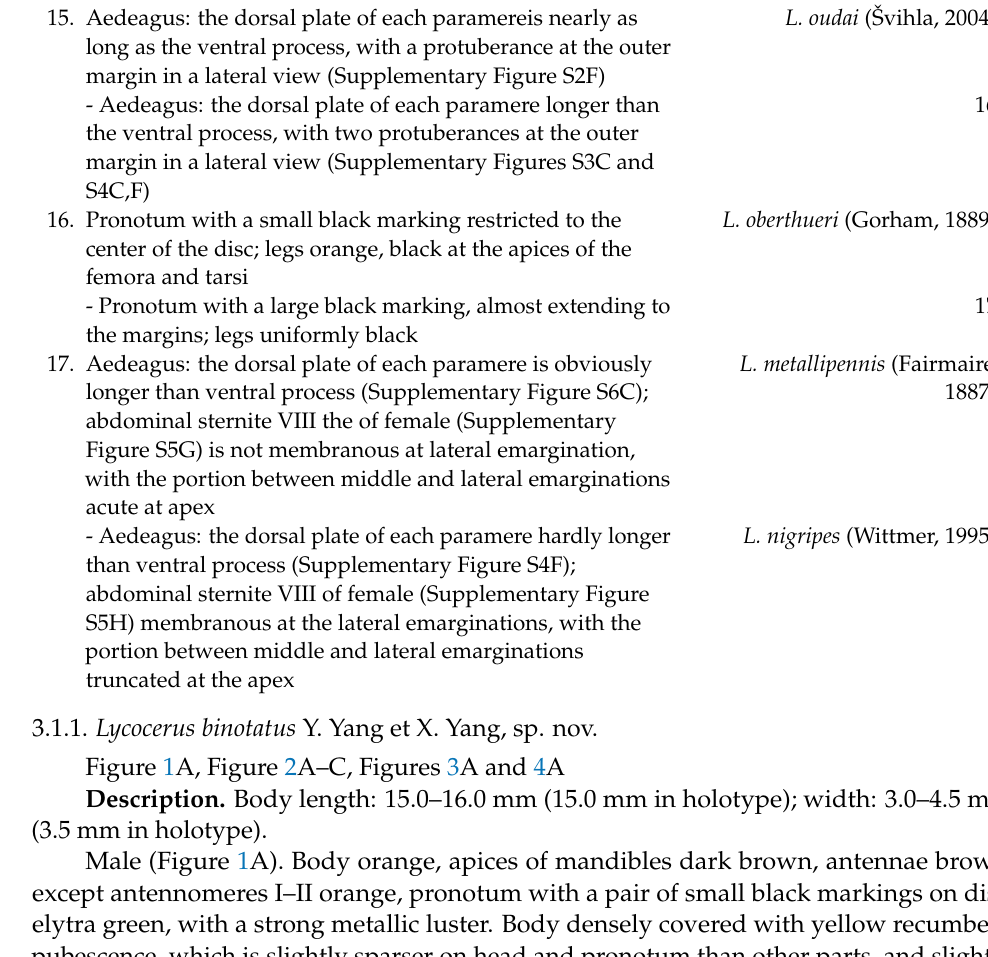
L. nigripes (Wittmer,